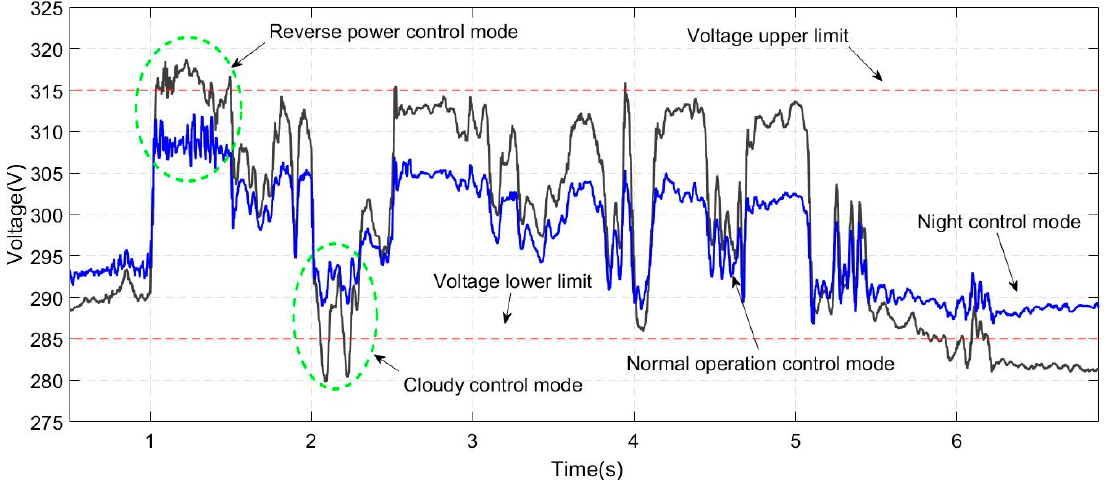
Figure 18. Waveforms of V PCC under power factor control strategy and integrated control strategy.